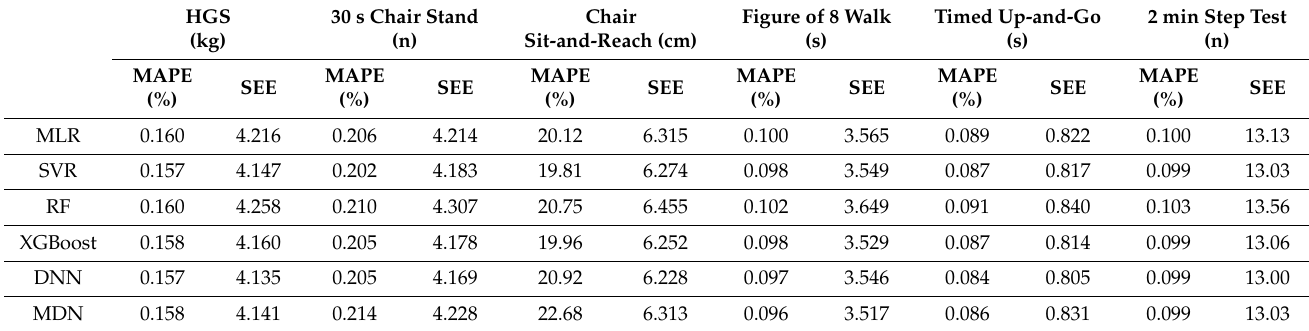
Table 6. Validation of estimating